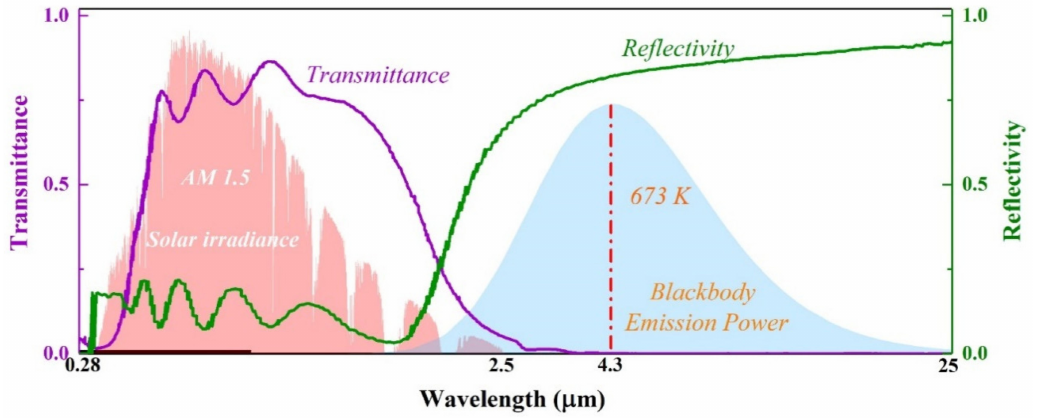
Figure 3. Spectral characteristics of the TCO